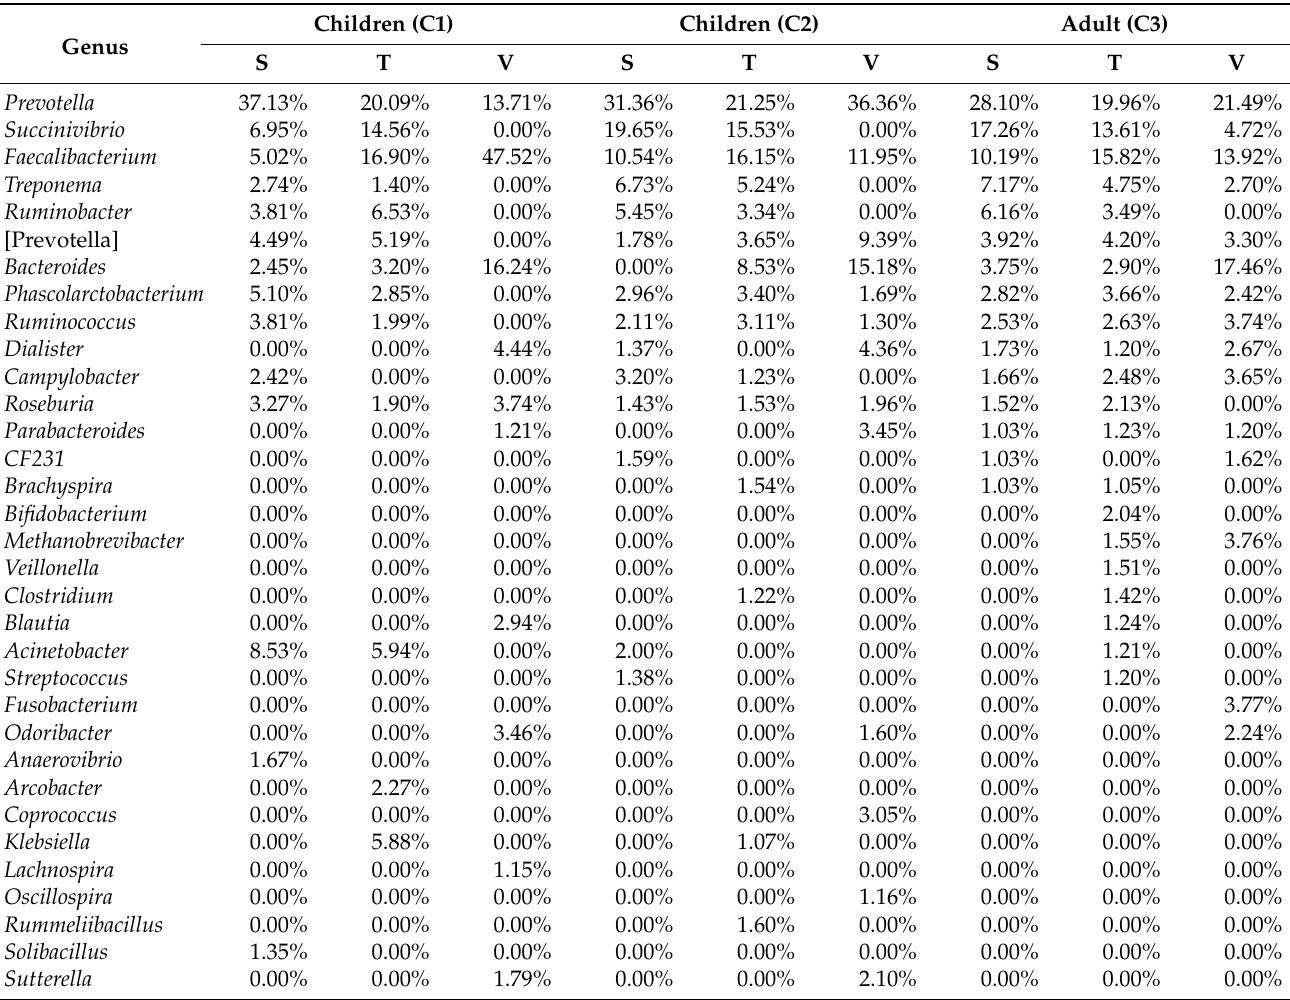
Table A9. Genera distribution through the age groups for the three locations: Siminke (S), Tezhumake (T), and Valledupar